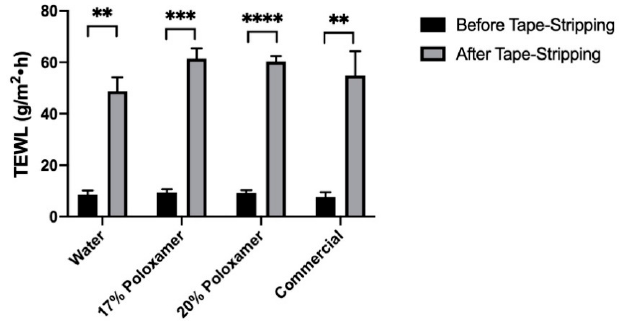
Figure 7. Transepidermal water loss (TEWL) results after tape stripping of skin samples used for the permeation testing in impaired skin samples. The X axis shows what diclofenac formulation was applied to those impaired skin samples. Number of tape strips used varied between samples (described in Methods section). Data presented as mean ± SD ( n = 3). ** p < 0.01, *** p < 0.001, **** p < 0.0001.